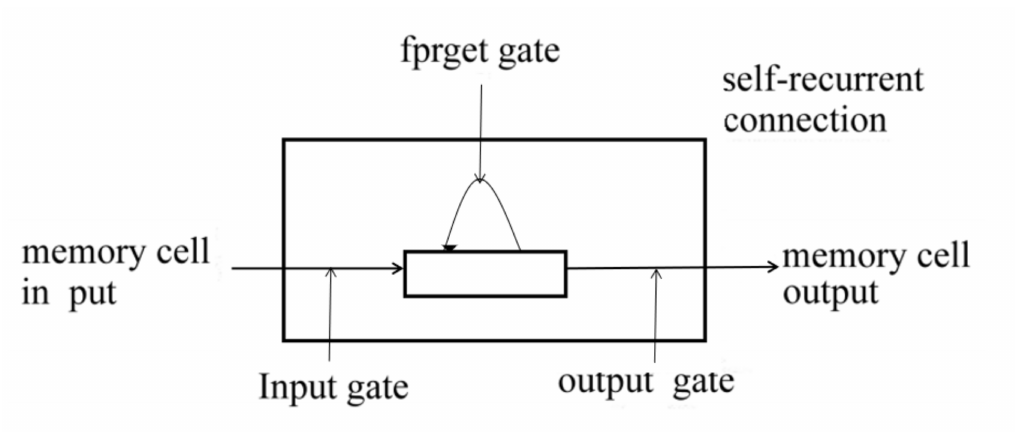
Figure 5. LSTM memory